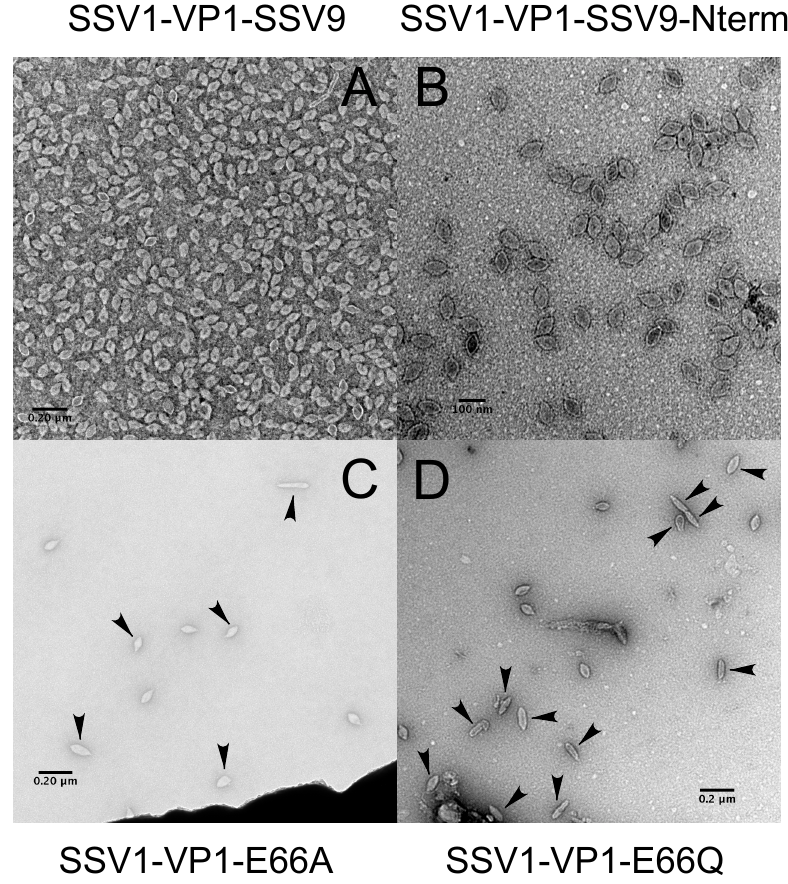
Figure 3. Transmission electron micrographs of SSV1 VP1 mutants. Negatively stained SSV1 mutant virions were imaged using a Tecnai F-20 (FEI) transmission electron microscope operating at 200 keV. The culture supernatant in ( Panel A ) was concentrated ca. 100 fold with a Vivapsin-500 (10 kDa cutoff) concentrator. ( Panel A ) Virions from SSV-1 containing the VP1 gene from SSV9; ( Panel B ) Virions from SSV-1 containing a VP1 gene with the N-terminus of the gene from SSV9; ( Panel C ) Virions from SSV-1 containing a VP1 gene with the E66A substitution; ( Panel D ) Virions from SSV-1 containing a VP1 gene with the E66Q substitution. Arrowheads in ( Panels C,D ) indicate “abnormal” particles.